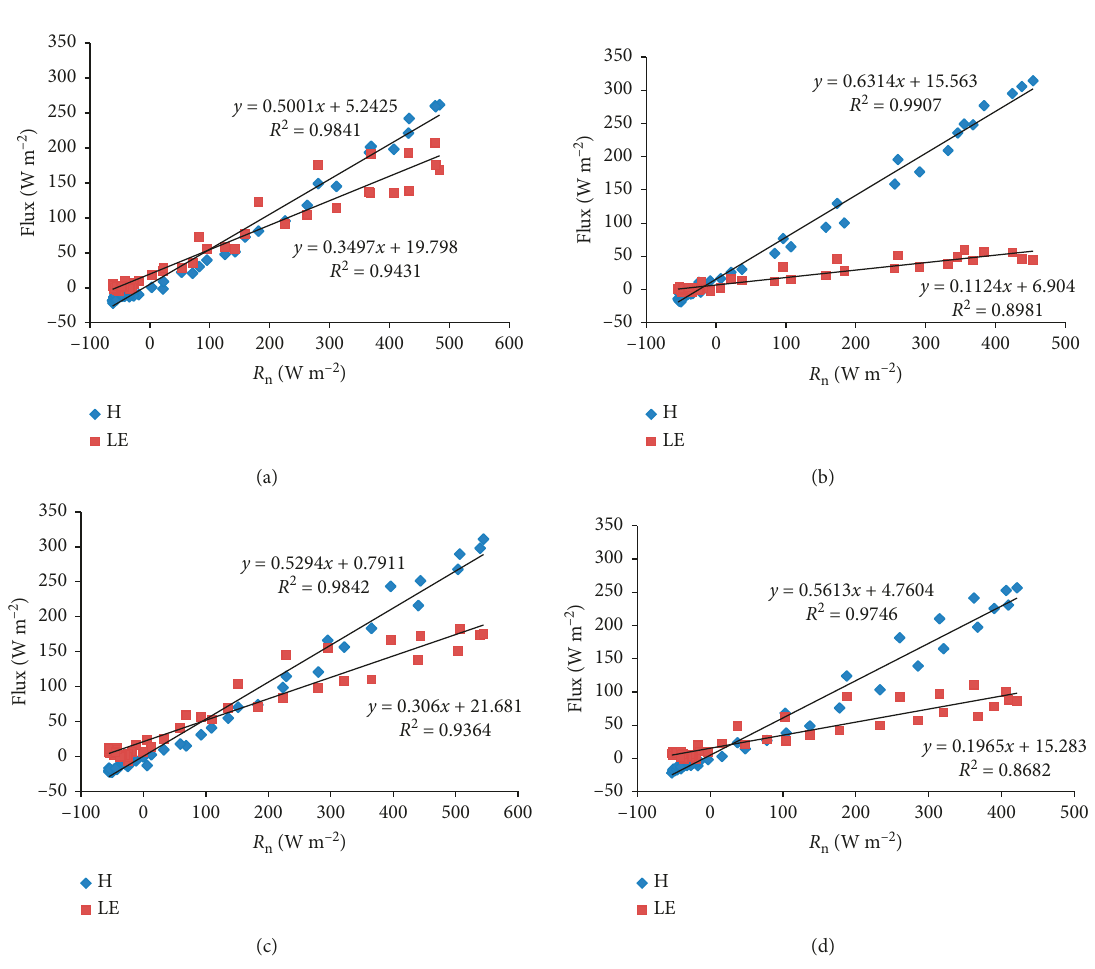
n for the season of (a) warm 2005, (b) cool 2005, (c) warm 2006, and (d) cool 2006. H LE